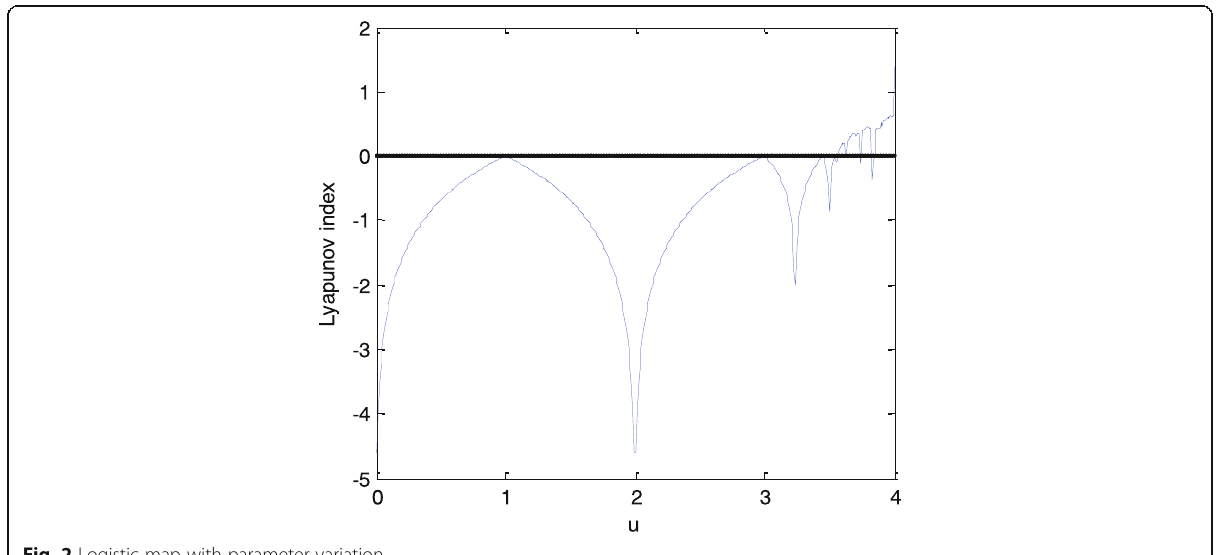
Fig. 2 Logistic map with parameter